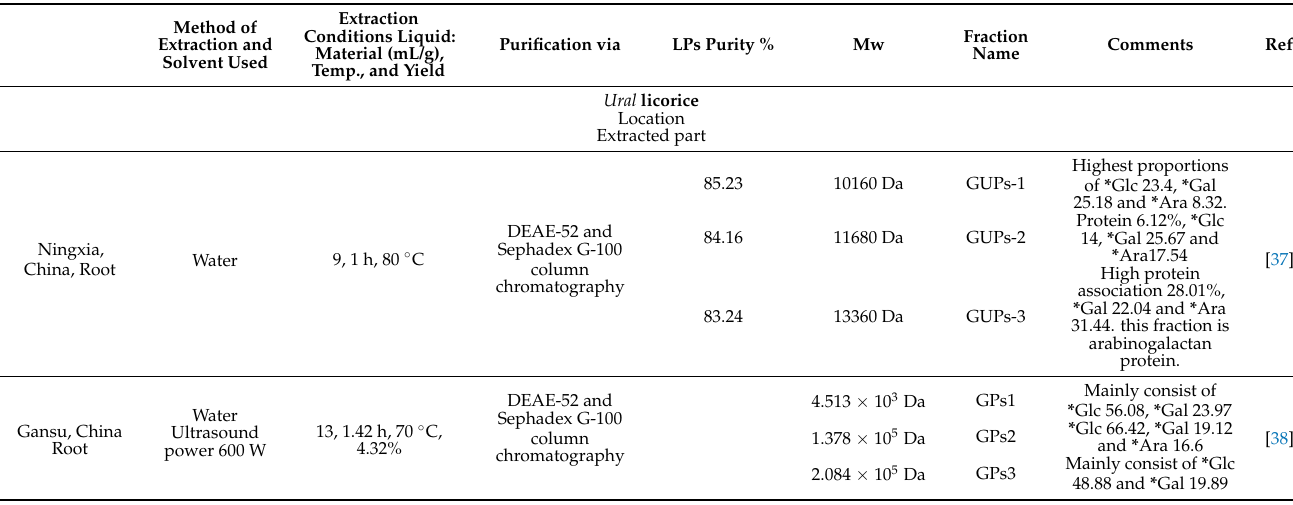
Table 1. Examples of extraction and purification